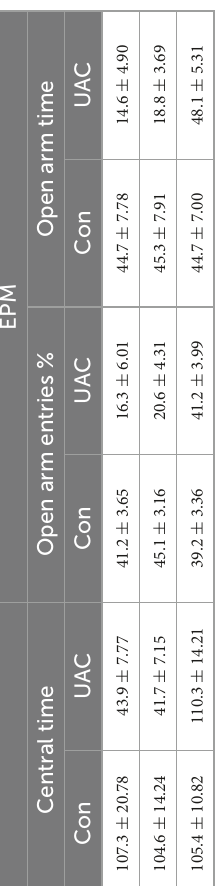
Table 4 ; EPM: open arm entries, F ( 2 , 38 ) = 7.416, p = 0.0019; Table 4 ]. The inhibition of Vpdm-VPM-projecting neurons (hM4Di-CNO group) increased percentage of central distance ( vs. mCherry-CNO, p = 0.0380; vs. hM4Di-SAL, p = 0.0105, Figure 5E ) and the time spent in the central zone ( vs. Figure 5E ) in the OFT. In the EPM, the inhibition of Vpdm-VPM-projecting neurons increased the percentage of the open arm entries ( vs. mCherry-CNO, p = 0.0022; vs. hM4Di-SAL, p = 0.0075, Figure 5F ) and the time spent in the open arms ( vs. mCherry-CNO, p = 0.0094; vs. hM4Di- SAL, p = 0.0163, Figure 5F ). Moreover, the chemogenetic virus (hM4Di-SAL group) and CNO injection (mCherry-CNO group) did not have substantial effects on locomotor abilities or anxiety-like behaviors. These chemogenetic results reveal that specific inhibition of Vpdm-VPM-projecting neurons produces antianxiety effects in UAC